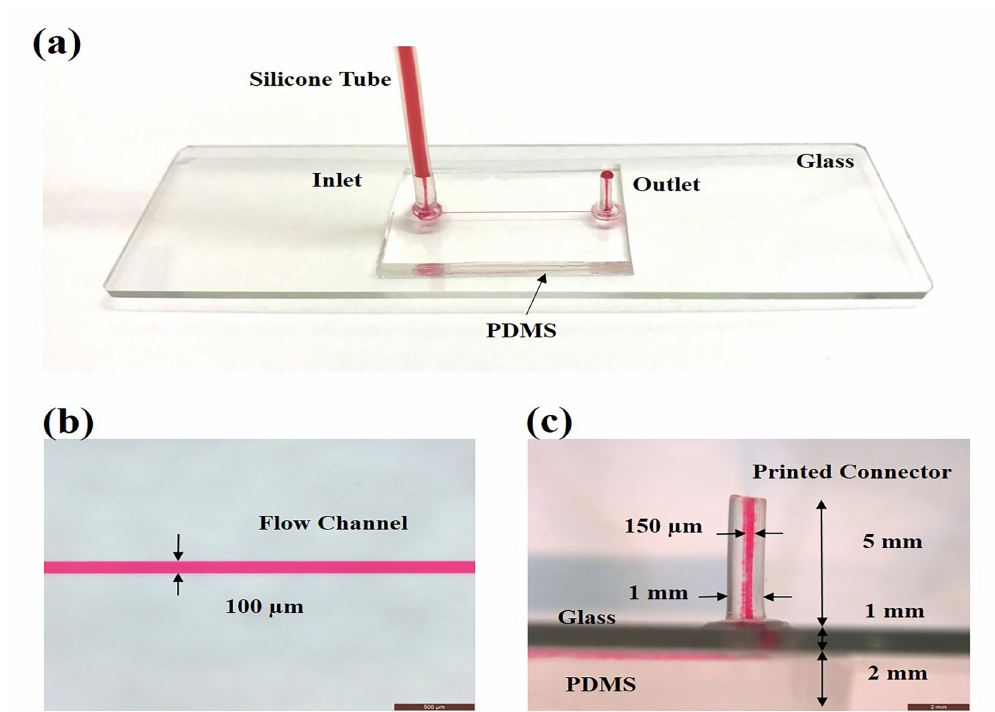
Figure 9. Demonstration of printed connectors for microfluidic interconnections: overview ( a ); top view ( b ); and side view ( c ) of the typical PDMS–Glass microfluidic device with printed hollow